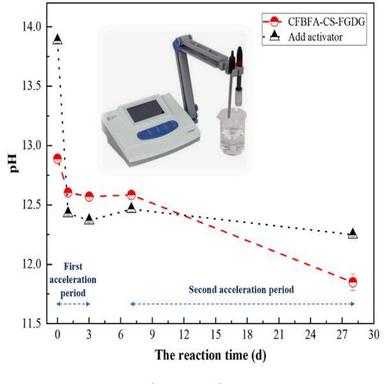
pH analysis.